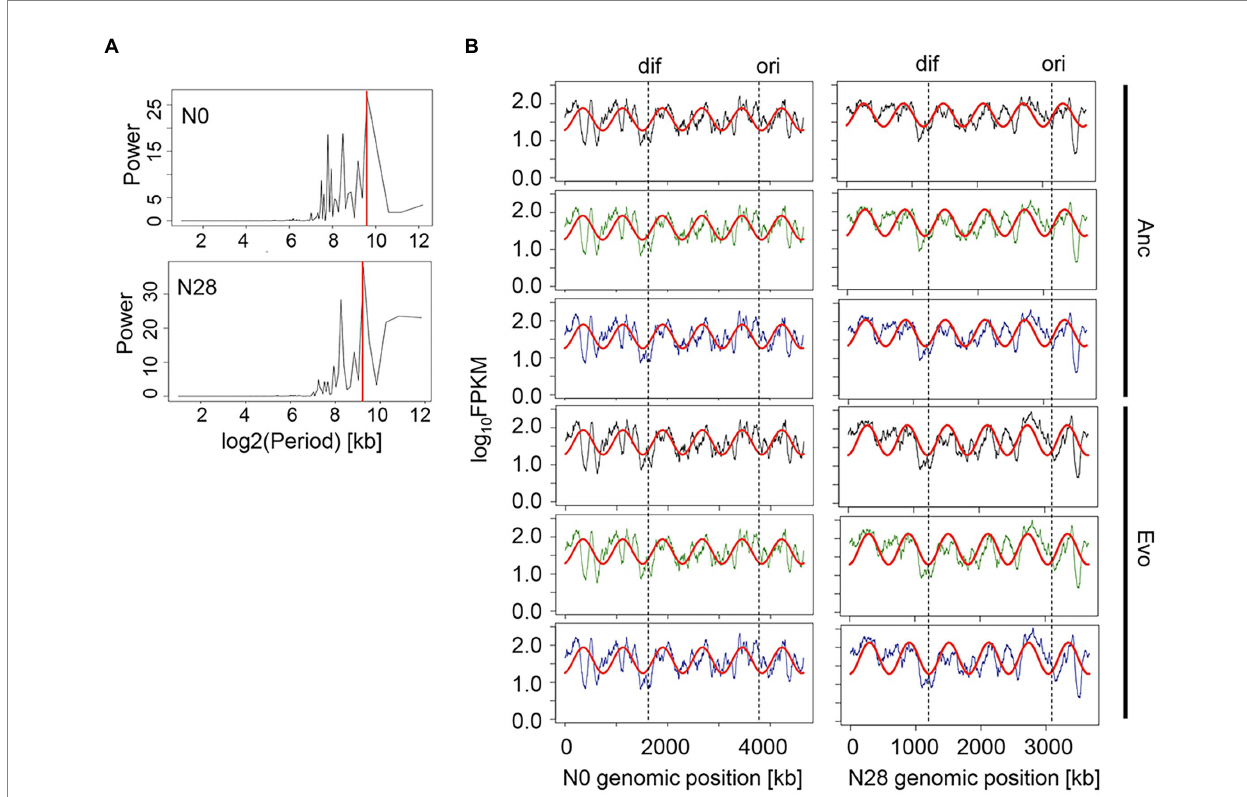
FIGURE 3 Chromosomal periodicity of transcriptomes. (A) Fourier transform. The examples of N0 and N28 are shown. The red lines indicate the highest power spectra (max-peak) estimated by the Fourier transform. (B) Chromosomal periodicity. The red curves represent the fitted periods of the transcriptomes according to the max-peaks estimated by the Fourier transform. The transcriptional levels for every 1-kb sliding window and 100-kb smoothing are shown. Ori and dif are indicated. The left and right panels show the wild-type and reduced genomes, respectively. Anc and Evo represent the ancestral and evolved populations, respectively. Green and blue indicate the addition of Thr and Cm in the culture,